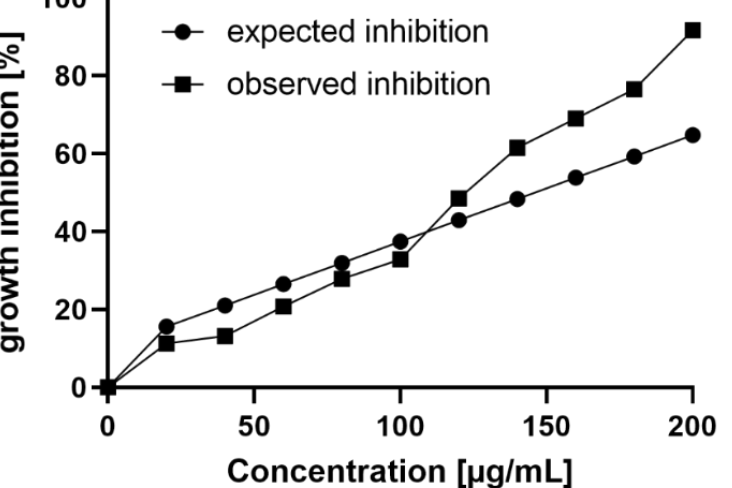
Figure 3. Expected and observed growth inhibition of the chitosan hydrolysate against F. graminearum . The observed growth inhibition is stronger than the expected growth inhibition at concentrations above 100 µg/mL.